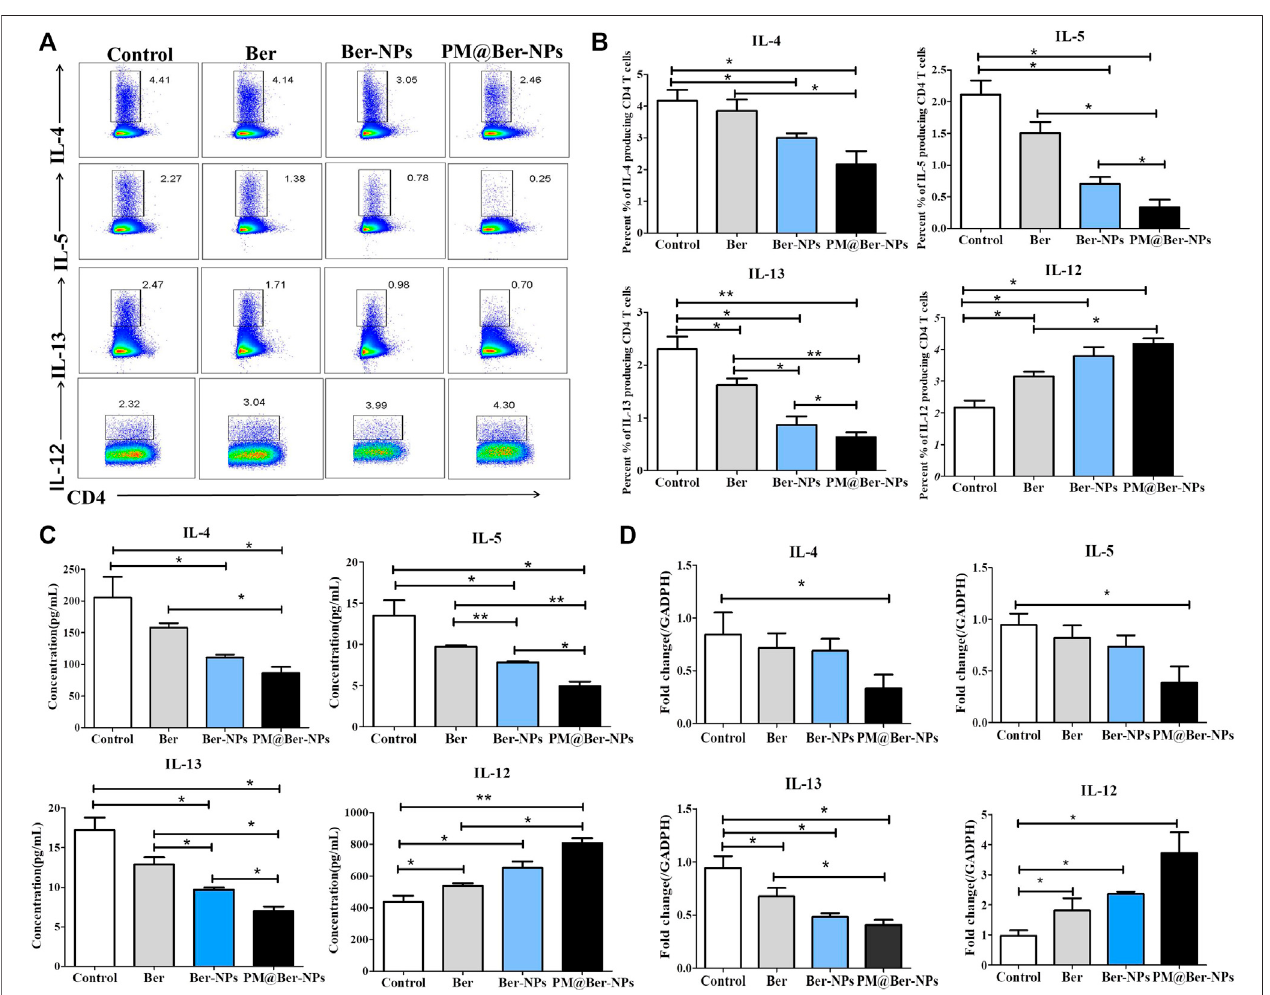
FIGURE5| Ber-loadedbiomimeticNPsdecreaseTh2typecytokinesexpressionbutenhanceIL-12expressioninlungsofasthmaticmice. (A) Cytokinessecretory in the lungs from HDM-induced asthma mice ( n (cid:1) 5) were isolated and followed by fl ow cytometry analysis. (B) Percentages of cytokines secretory in the lungs from HDM-induced asthma mice were counted. (C) Th2 type cytokines (IL-4, IL-5, and IL-13) and IL-12 serum from asthmatic mice were determined by ELISA kit. (D) The mRNA expression of cytokines was examined by real-time RT-PCR. * p < 0.05; ** p < 0.01.